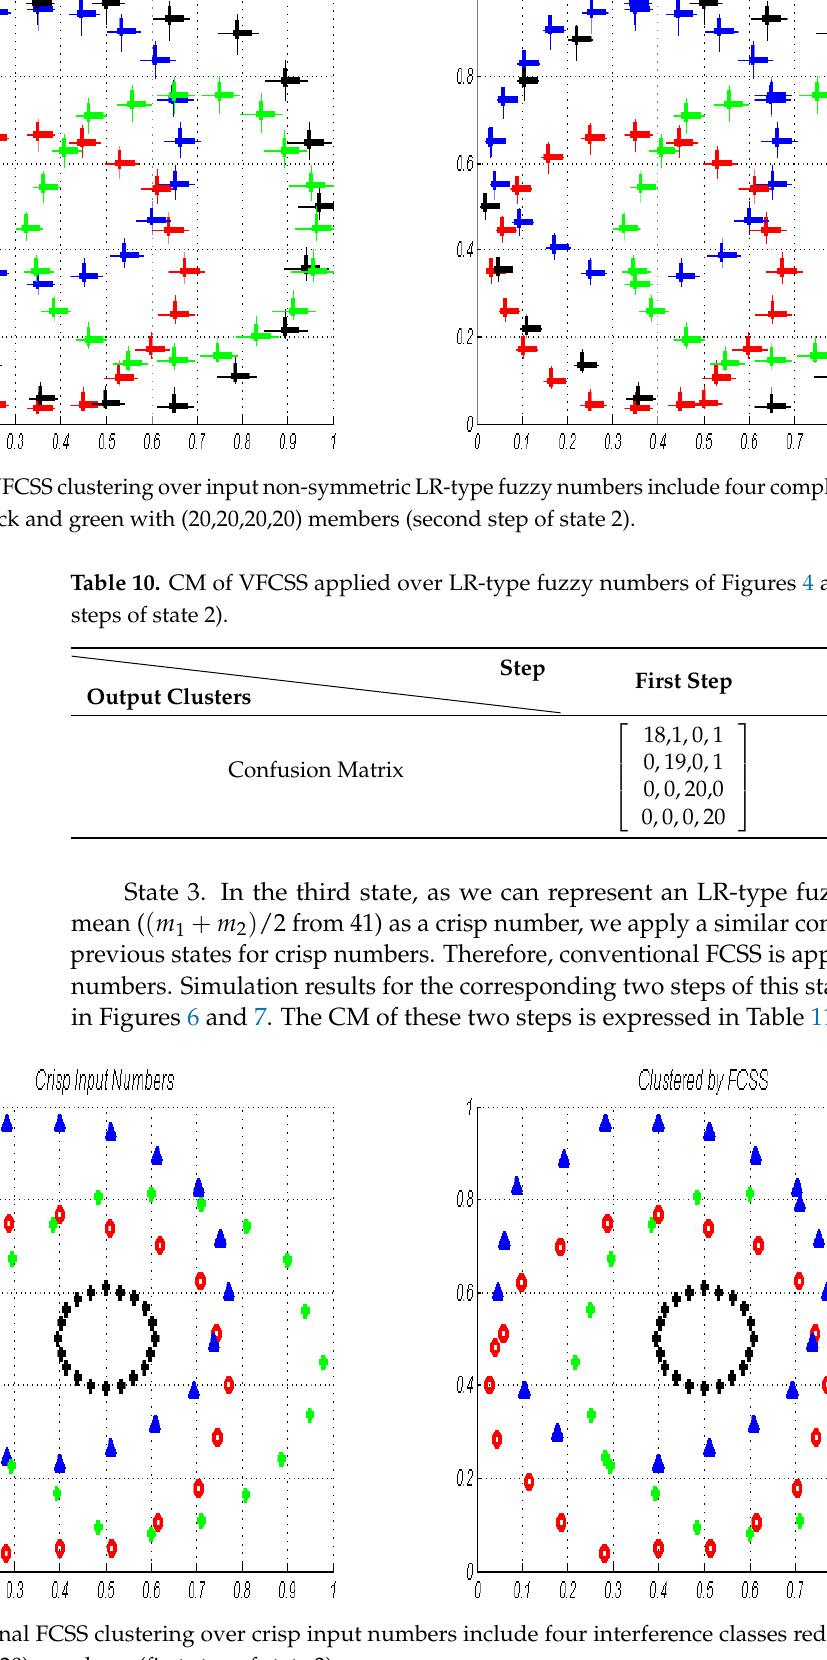
Figure 6. Conventional FCSS clustering over crisp input numbers include four interference classes red, blue, black, and green with (20,20,20,20) members, (first step of state